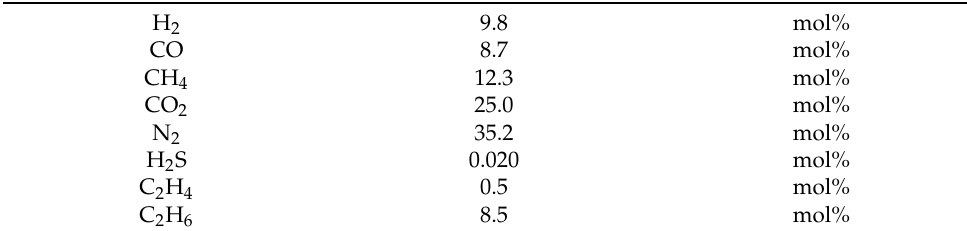
Table 3. Molar fraction of pyrolyzed